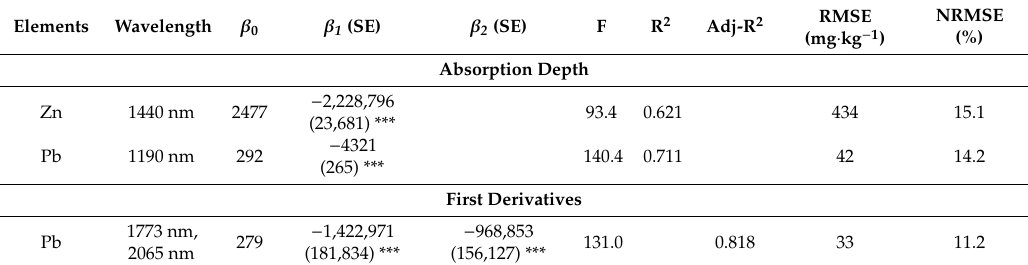
Table 5. Parameter for fitting the reflectance, absorption depth, and first derivatives to heavy metal